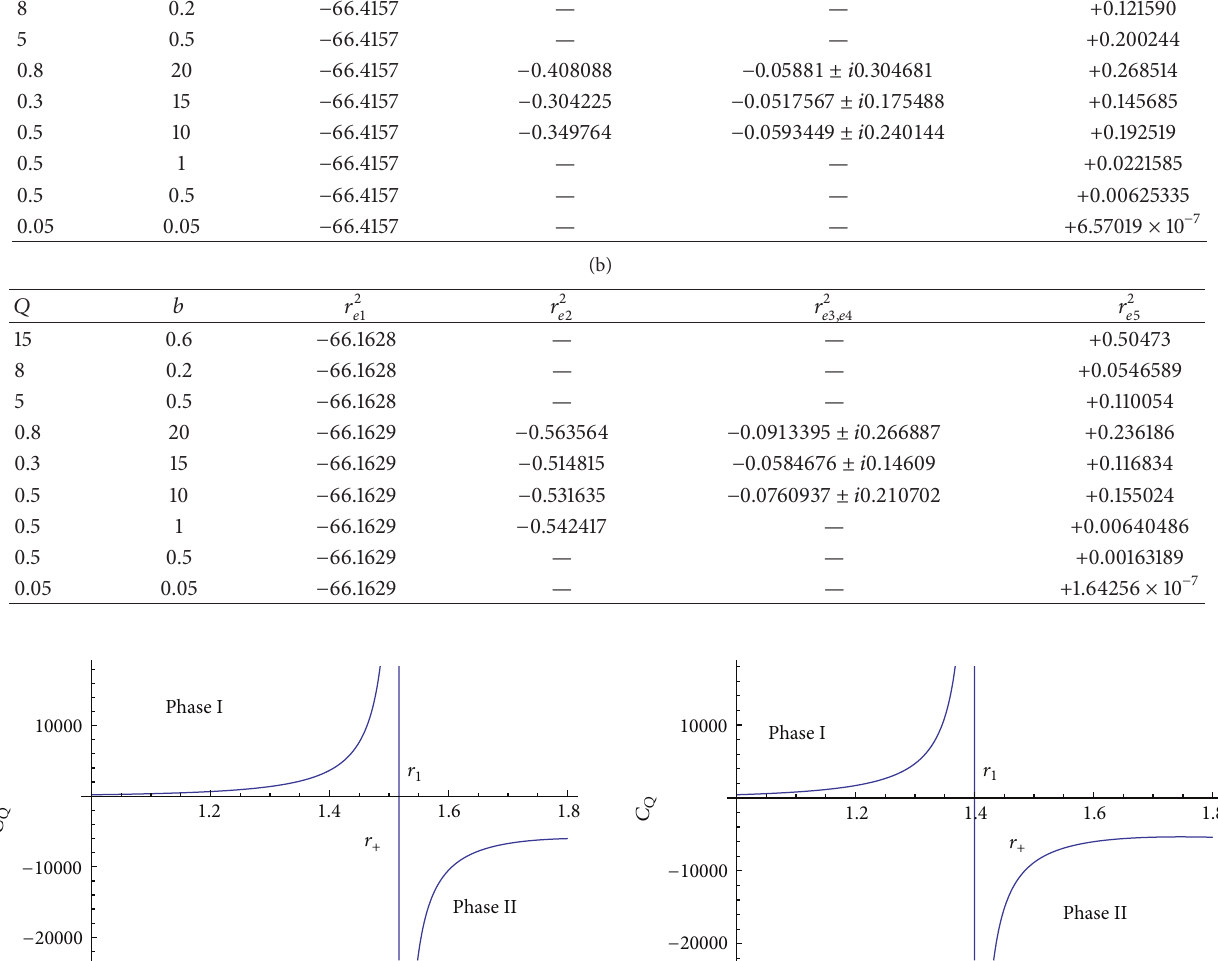
Figure 7: Plot of specific heat ( 𝐶 𝑄 ) against horizon radius ( 𝑟 + ), for 𝛼 󸀠 = 1.0 , 𝑄 = 5 , and 𝑏 = 0.5 at the critical point 𝑟